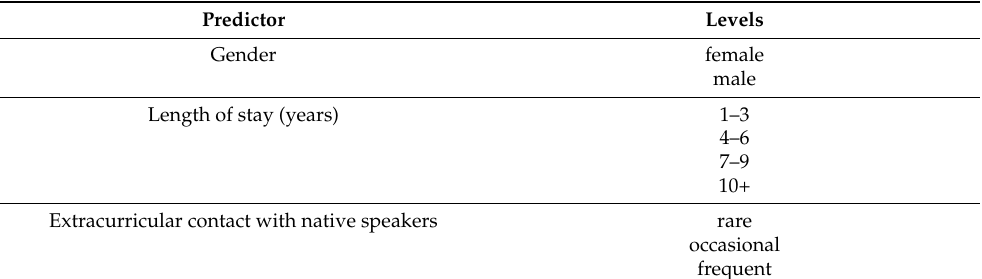
Table 3. Extralinguistic factors examined.